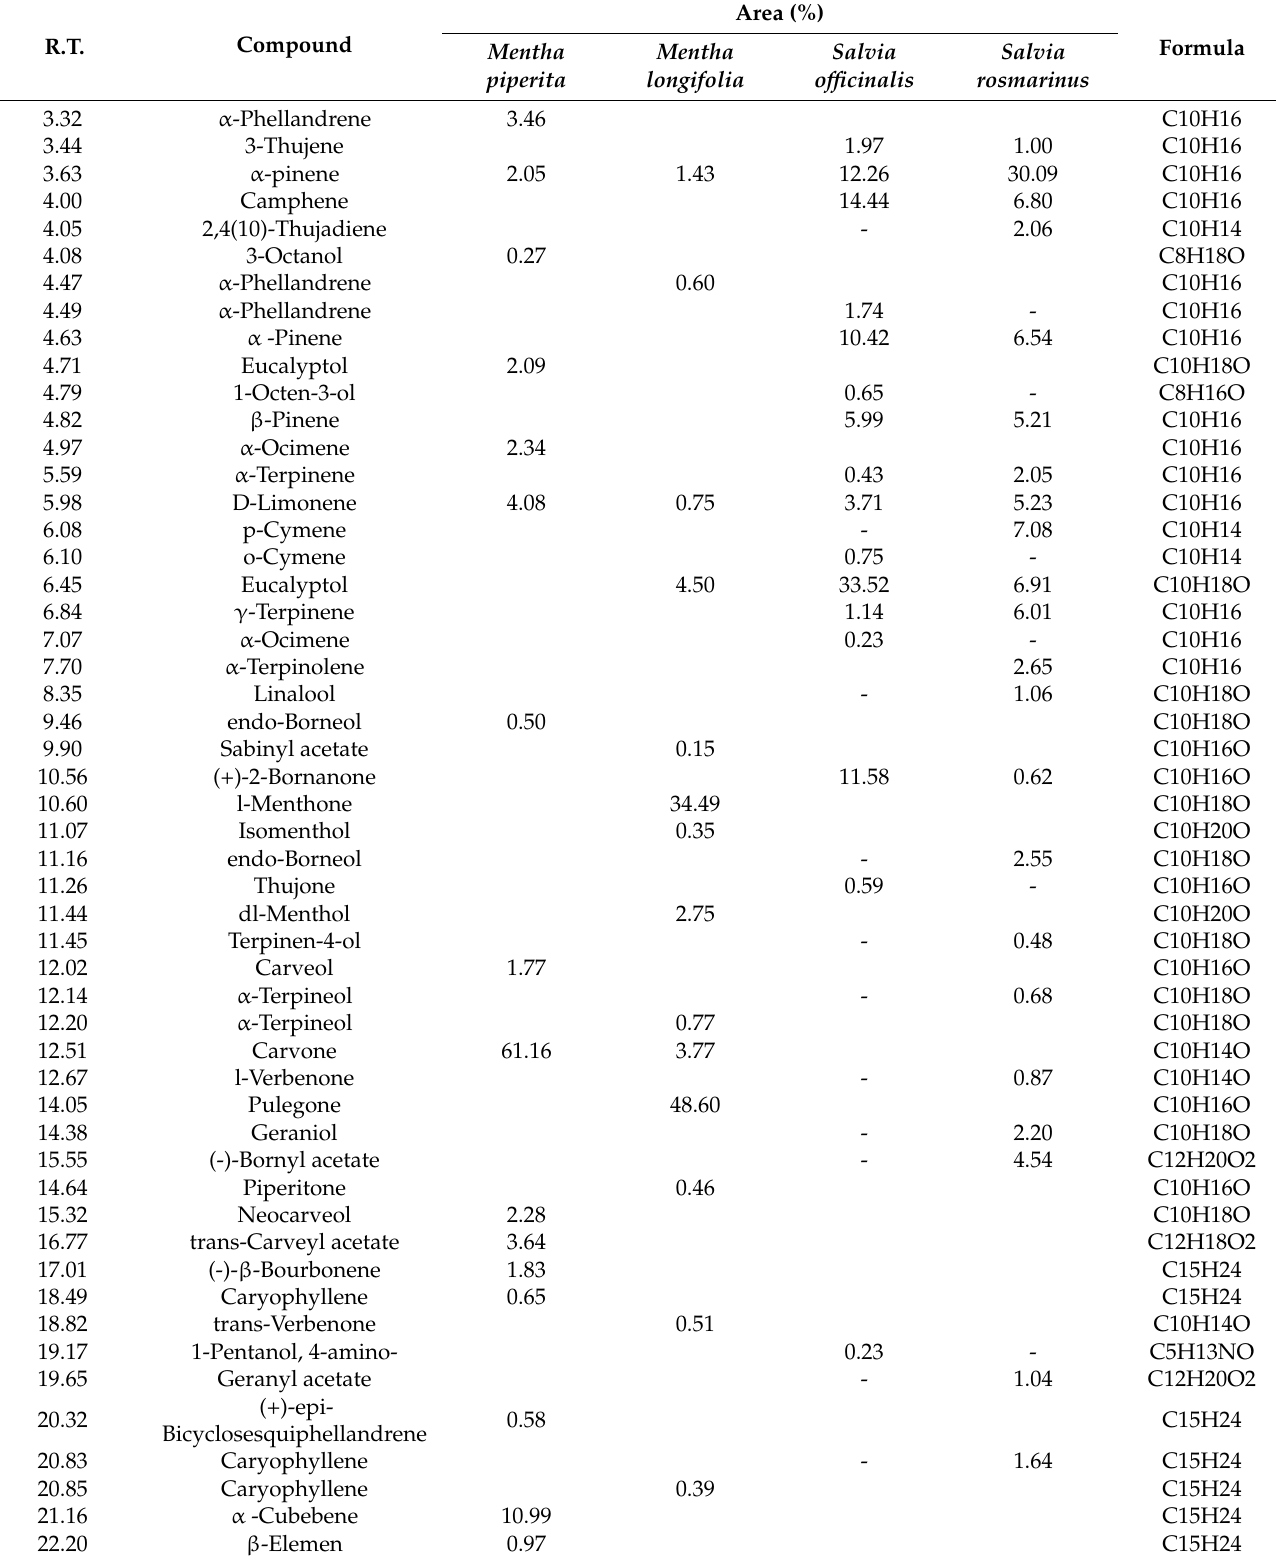
Table 1. Chemical composition (%) of essential oils of M. piperita, M. longifolia, S. officinalis, and S. rosmarinus